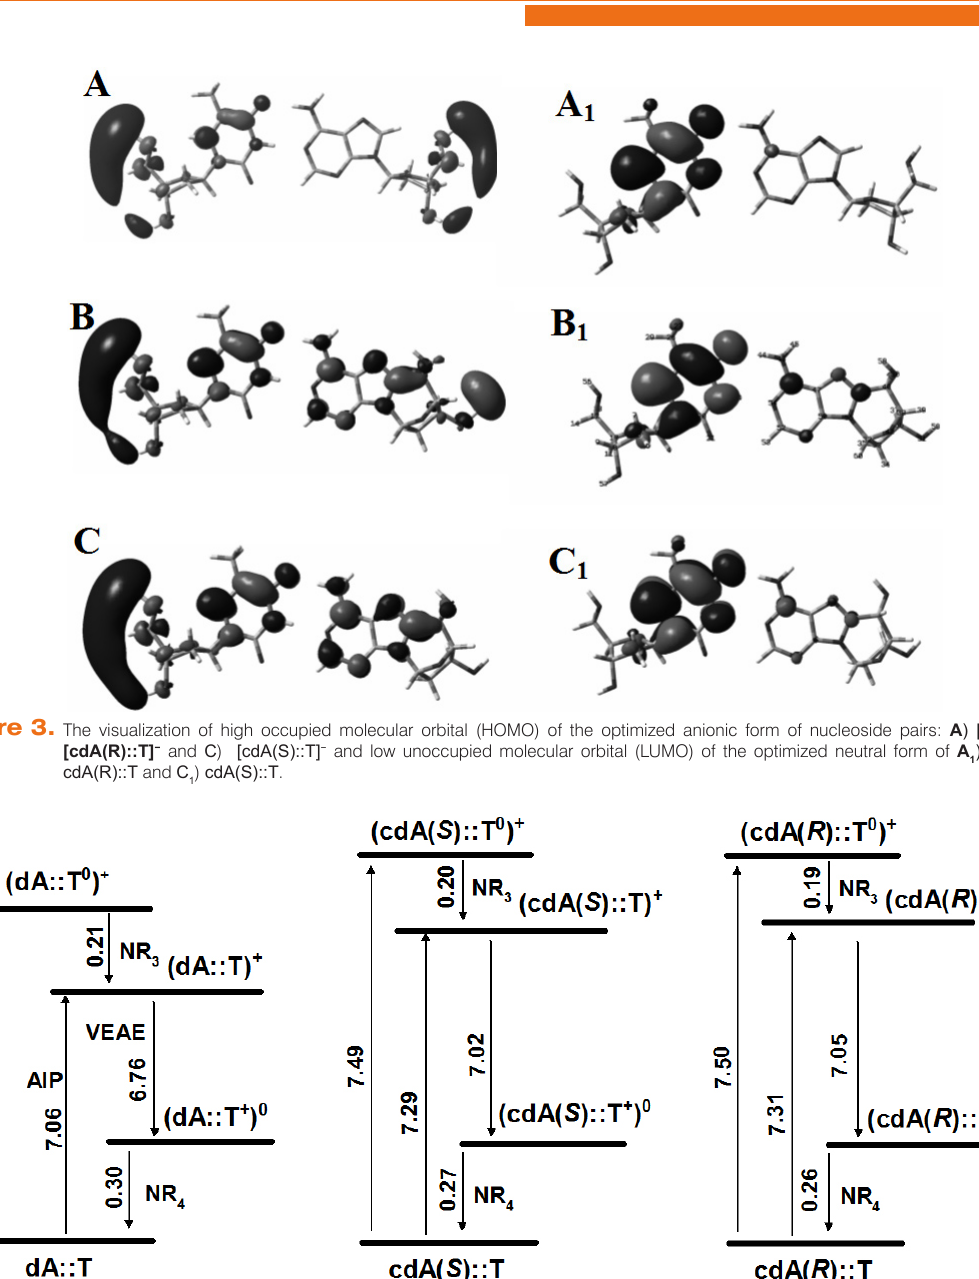
Figure 4. Scheme of energy, in eV, changes during the radical cation migration through cdA(S)::T , cdA(R)::T and dA::T nucleoside than that obtained for dA::T . These results indicate that the sugar unit attachment to adenine led to decreases in ionization energy, which deepened with Watson- Crick hydrogen bond formation. On the other hand, the appearance of additional covalent bonds at C5’-C8, as in cdAs , causes IP increase, especially in the case of 5’ S isomer (Table 1). Surprisingly, this effect was partially removed during nucleoside pair formation, and the IP values for cdA(S)::d and cdA(R)::T were as follows: 7.29eV and 7.31 eV, respectively. The differences in